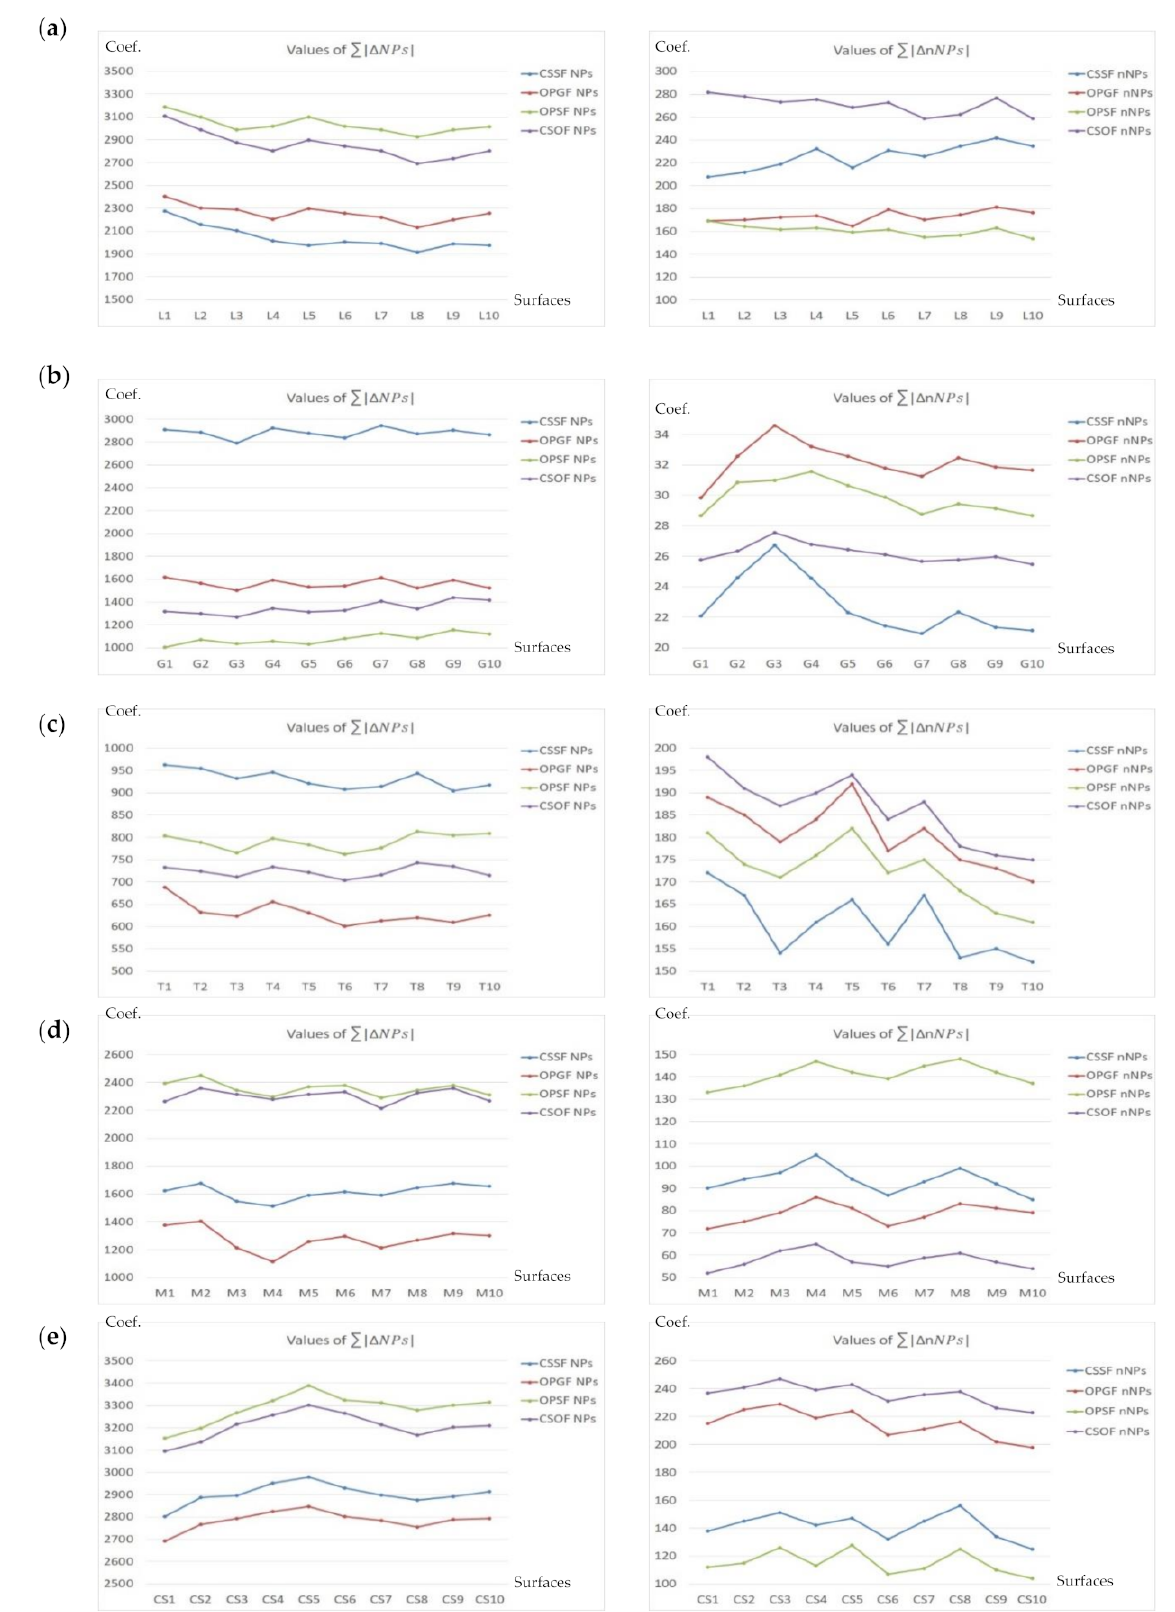
Figure 19. The values (presented in Coef. axis) of sums of NPs and nNPs, respectively, described for laser-textured ( a ), ground ( b ), turned ( c ), milled ( d ), and composite ( e )